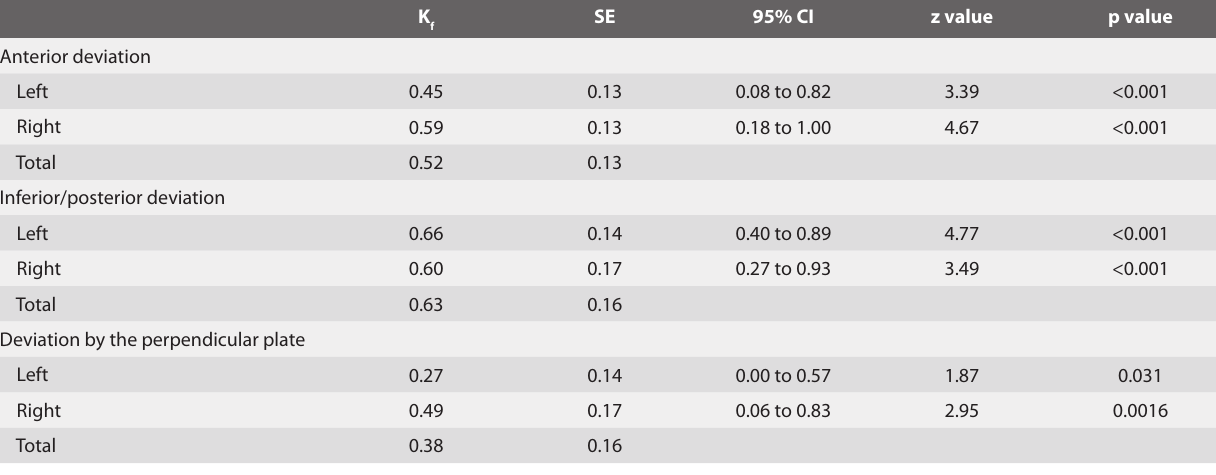
Table 3. Agreement analysis for radiologic evaluation of nasal septal